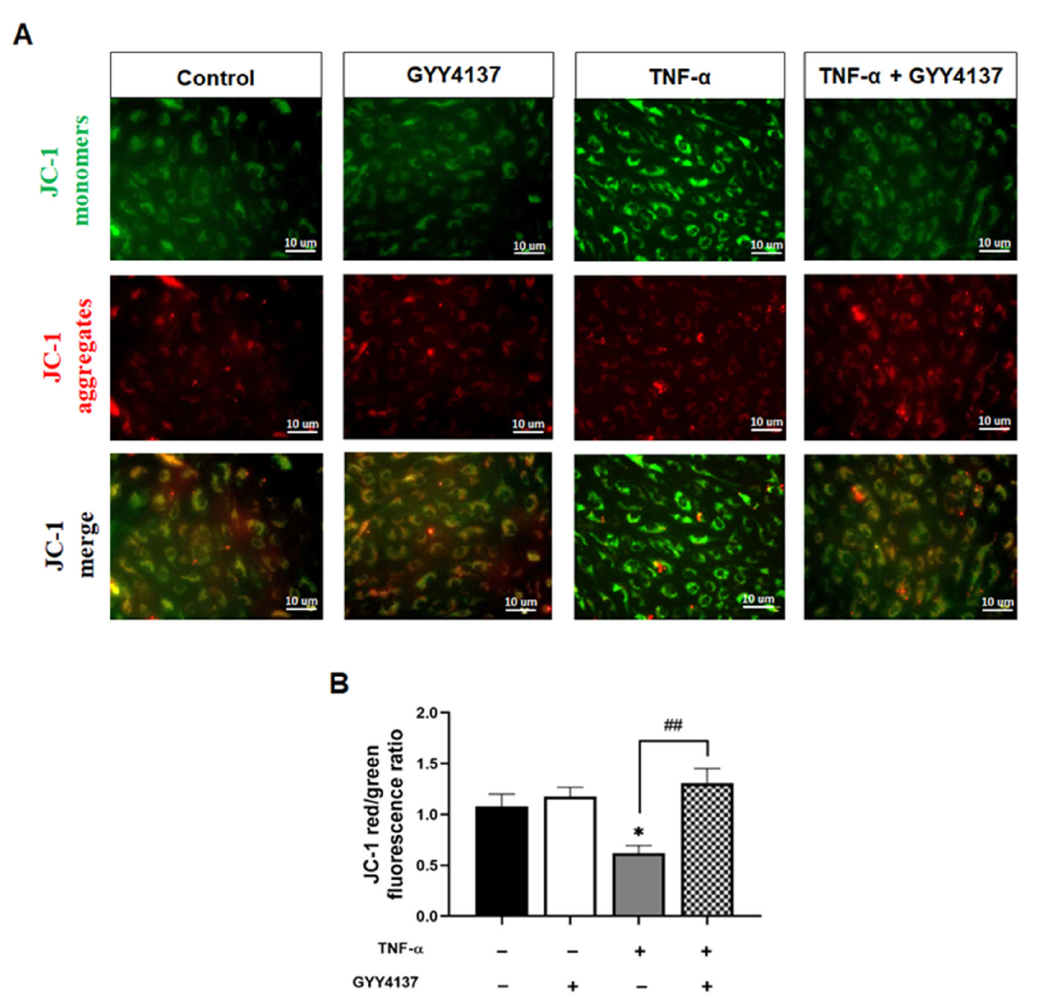
Figure 7. GYY4137 post-treatment prevents mitochondrial depolarisation mediated by TNF- α . ( A ) Representative fluorescence images showing mitochondrial membrane potential ( ∆ ψ m) detected by JC-1 staining. Scale bar 10 µ m. A decrease in the red (~590 nm)/green (~529 nm) fluorescence intensity ratio is indicative of depolarisation (n = 3). ( B ) Quantifying ∆ ψ m in the presence of TNF- α with GYY4137post-treatment in 4 fields with at least 40 cells was monitored. p -values were calculated using one-way ANOVA test followed by Tukey’s comparison test. Data are shown as means ± SD * p < 0.05 vs. control. ## p < 0.01 vs. TNF- α -treated groups only. N = 3 independent experiments with 3 replicate in each experiment.